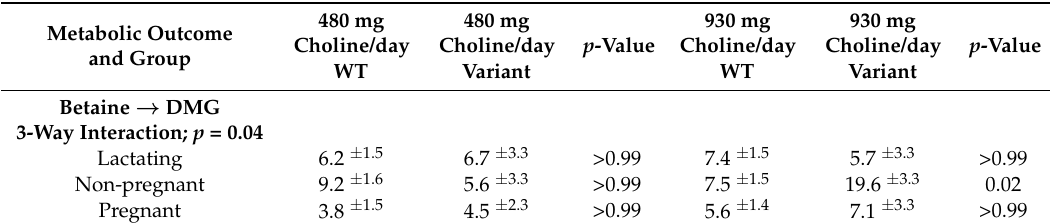
Table 15. SLC44A1 rs7873987 genotype alters the metabolic flux of betaine → DMG. Values are least-squared means ± standard errors in µ M DMG/study period. p -values represent the highest order interaction and pairwise comparisons between genotypes within intake groups.